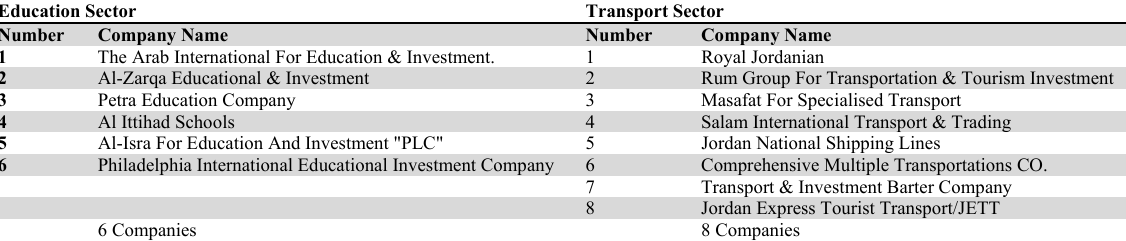
Done by the researcher based on Amman Exchange Stock Education